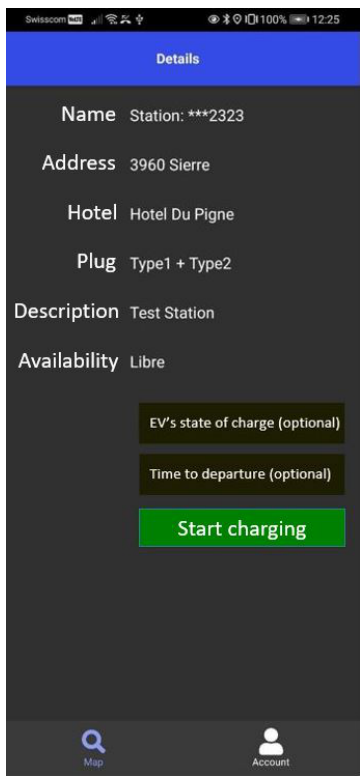
Figure 13. Charging station